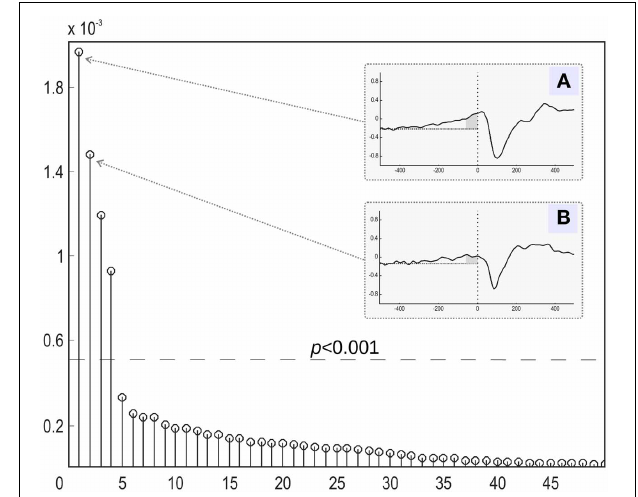
FIGURE 6 | We selected for ICA analysis 50 electrodes over the left sensory-motor cortex corresponding to the cortical representation of the right hand. Evoked response fields are shown. The selected sensors are framed.